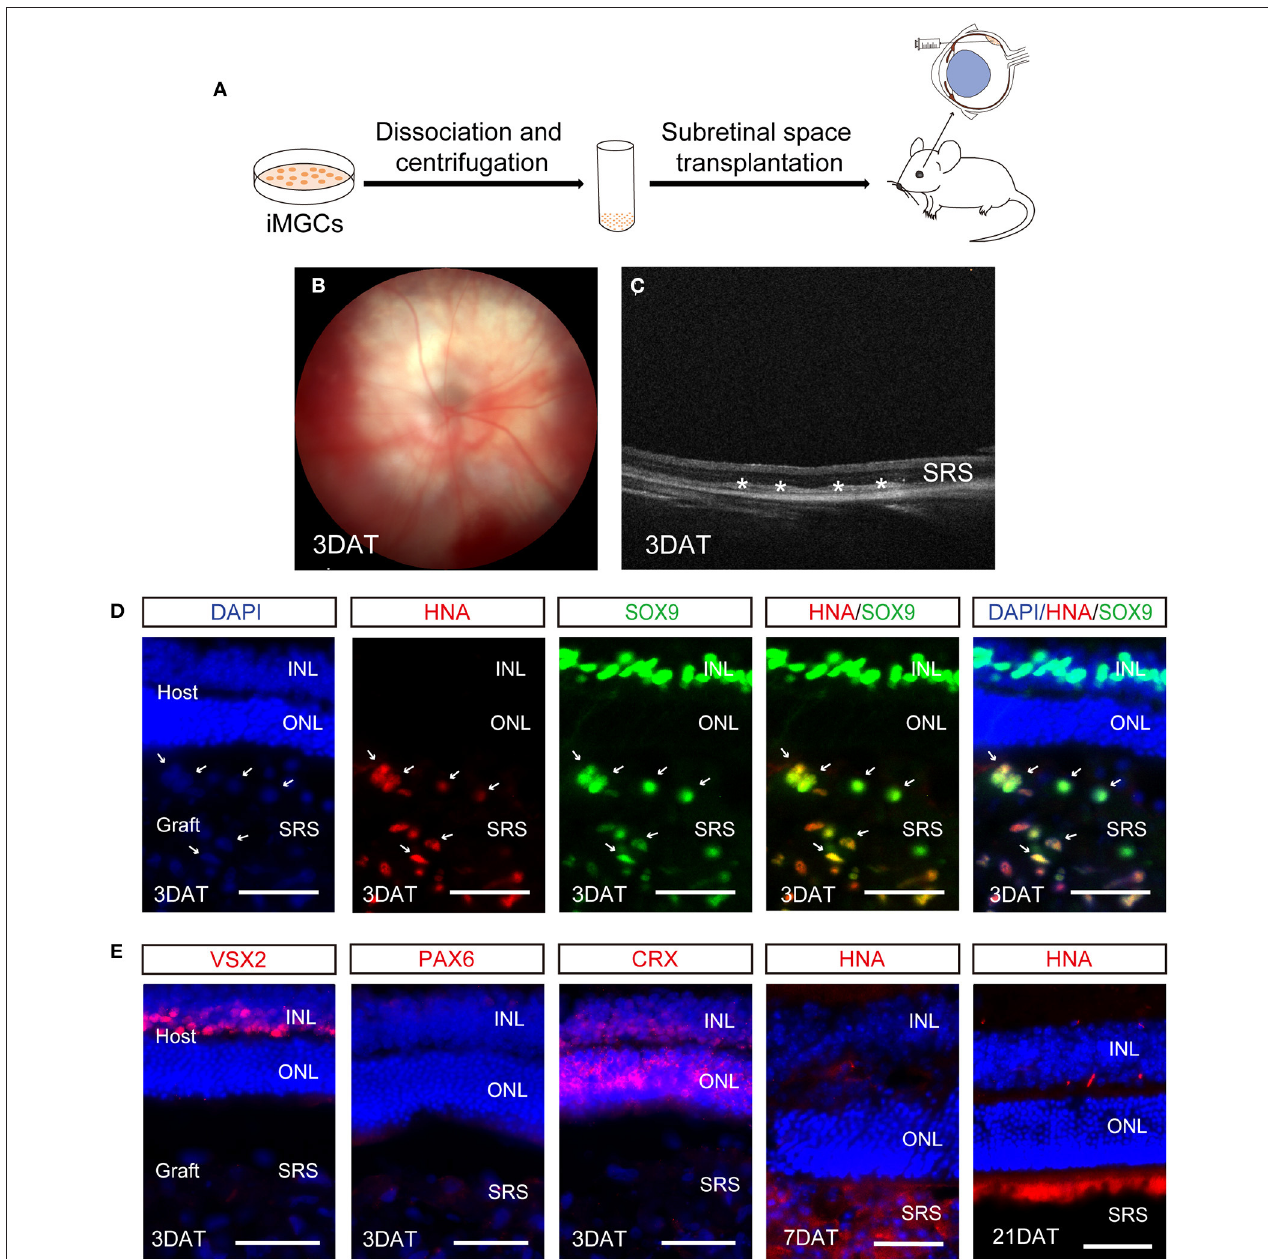
FIGURE 7 | Evaluation of cell survival of the passaged iMGCs after subretinal transplantation into NOD/SCID mice. (A) Schematic overview of the subretinal transplantation process of the iMGCs. (B,C) Fundus photography (B) and optical coherence tomography (OCT) (C) showed the successful delivery of the iMGCs into subreinal space (SRS) in NOD/SCID mice 3 days after transplantation (DAT). *The grafted cells. (D,E) Immunofluorescence staining showed the grafted iMGCs (D3, P2 iMGCs from D120 BC1-ROs) were positive for HNA and SOX9, but negative for VSX2, PAX6, and CRX at 3 DAT, and gradually disappeared from 7 to 21 DAT. INL, inner nuclear layer; ONL, outer nuclear layer. Scale bars = 50 µ m (D,E)